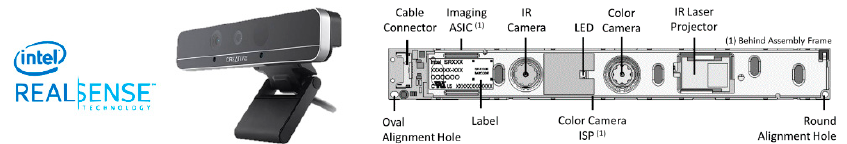
Figure 18. Intel RealSense SR300 sensor.